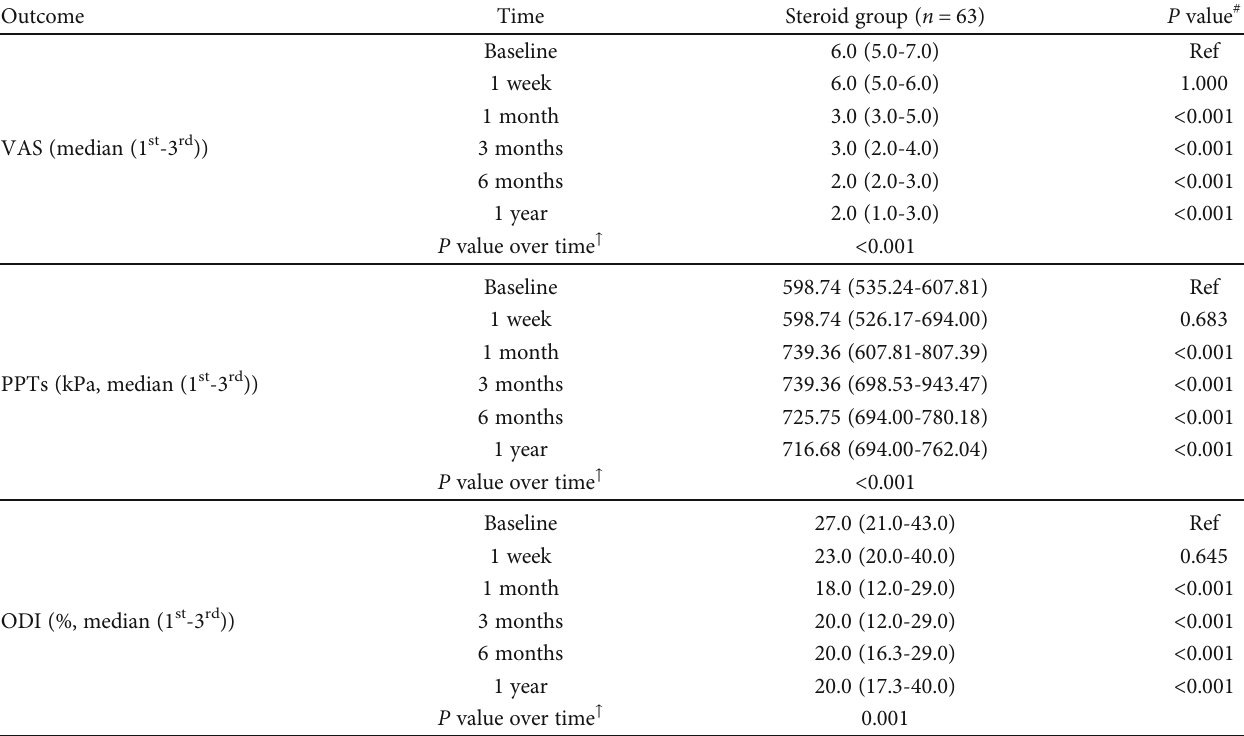
Table 4: Longitudinal outcomes of pain degree and spinal function for the steroid group over